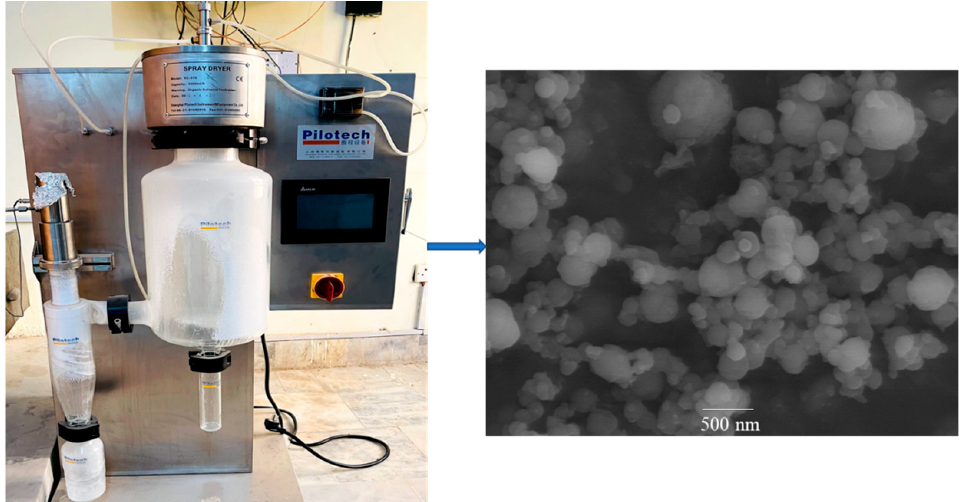
Figure 1. Photograph of spray dryer and SEM of 5FU-Alg-Np. Table 1. Size, zeta potential, and %DC of nanoparticles.